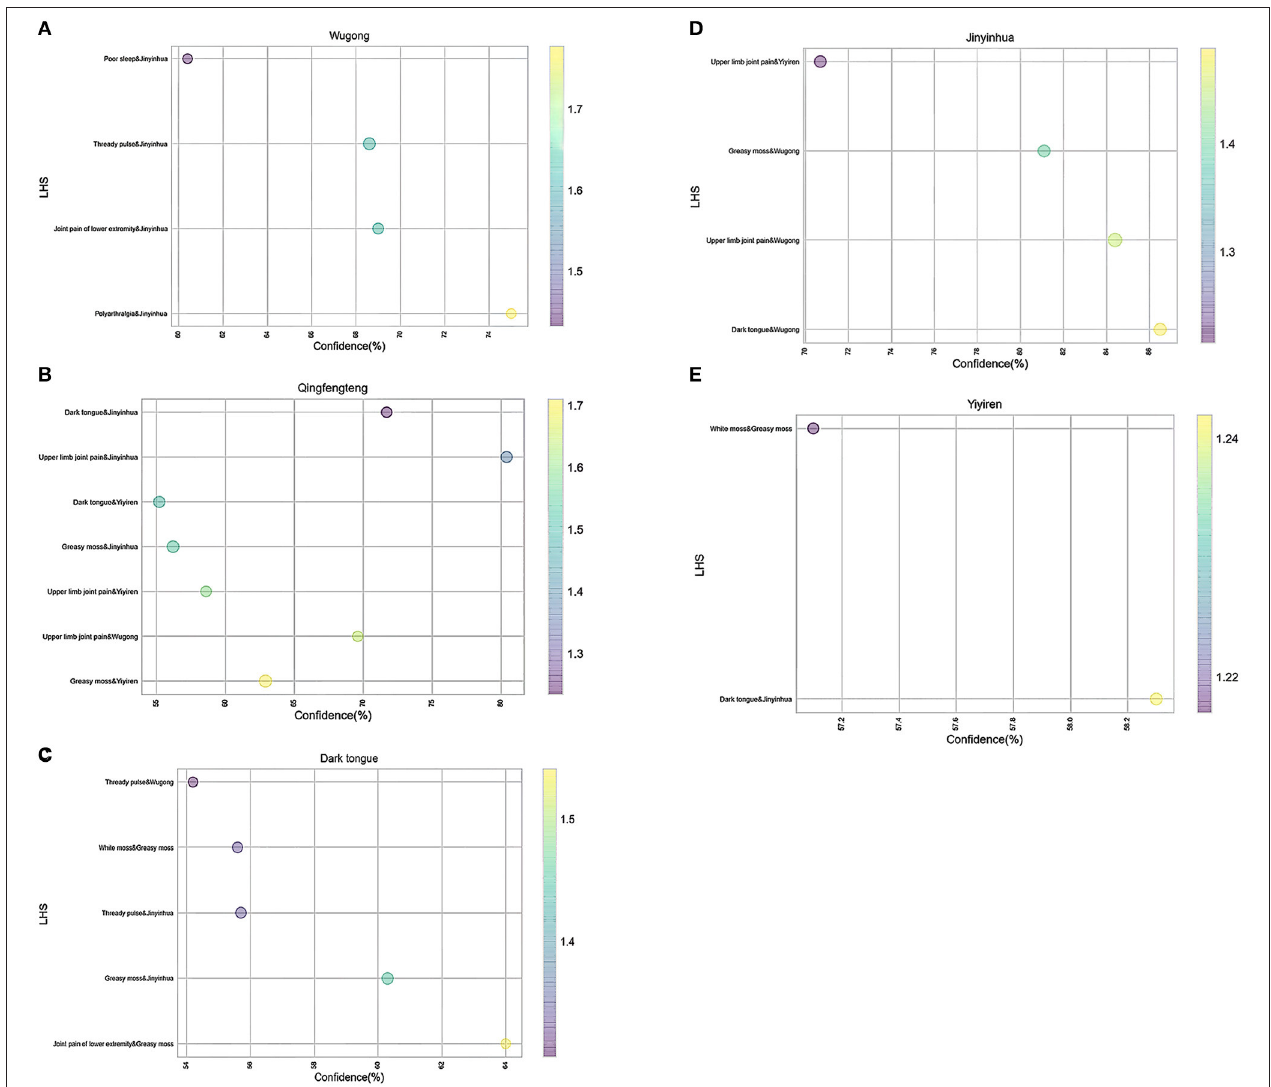
FIGURE 8 | (A–E) The bubble diagram of the third-order association between herbs and symptoms. (Title: “RHS”; X -axis: “Confidence”; Y -axis: “LHS”; Size: “Support”; Color: “Lift.” Data were analyzed by using Apriori association rule method and visualized by Python software).